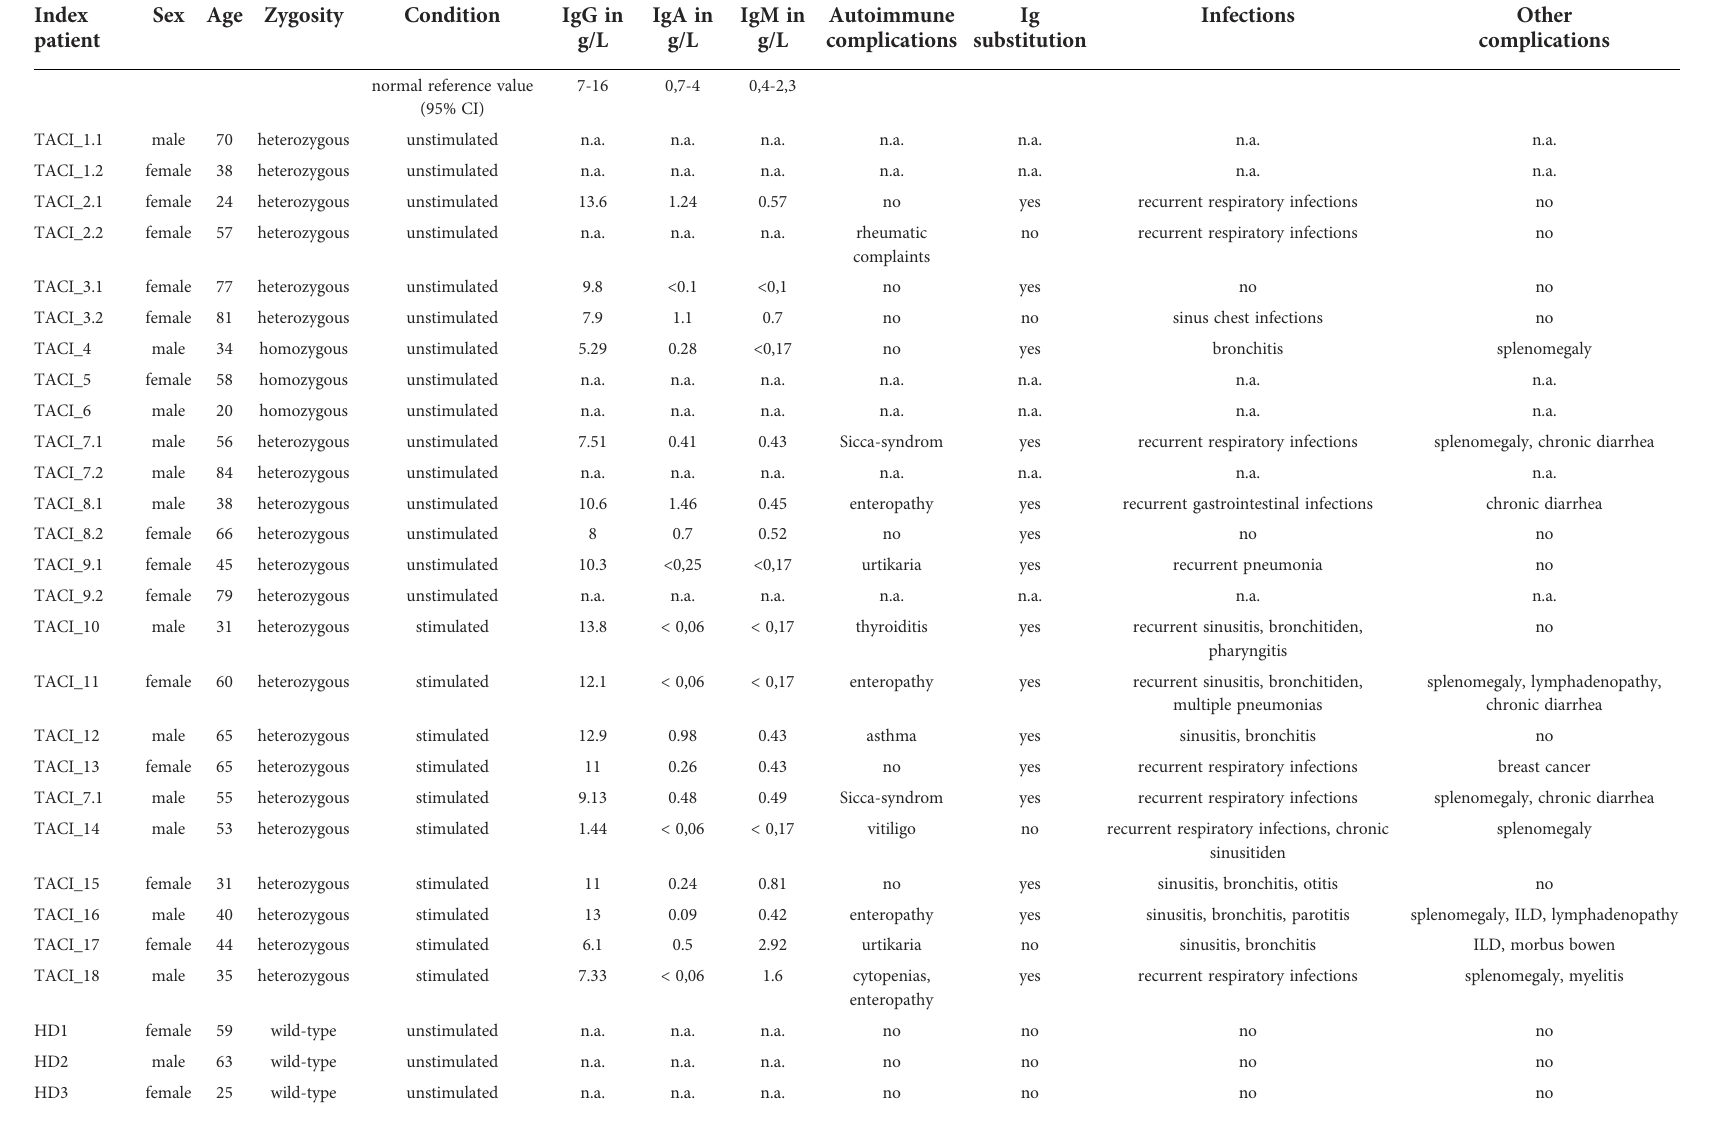
TABLE 1 Clinical overview of all investigated individuals. Index